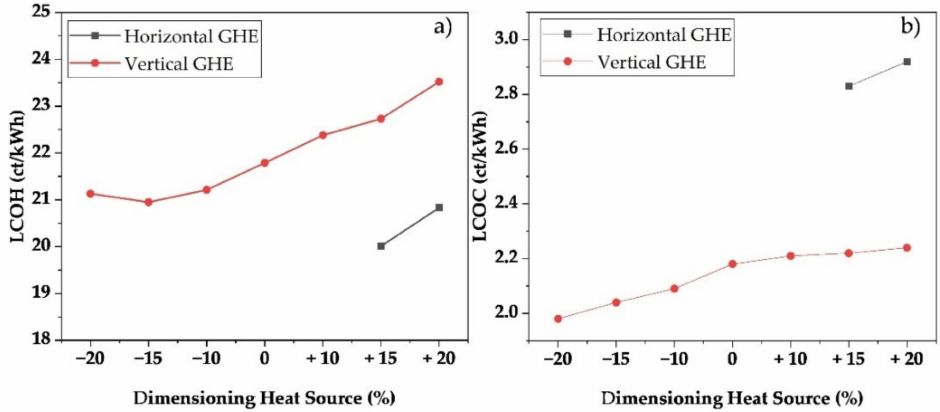
Figure 7. LCOH ( a ) and LCOC ( b ) for various dimensioning of the geothermal heat